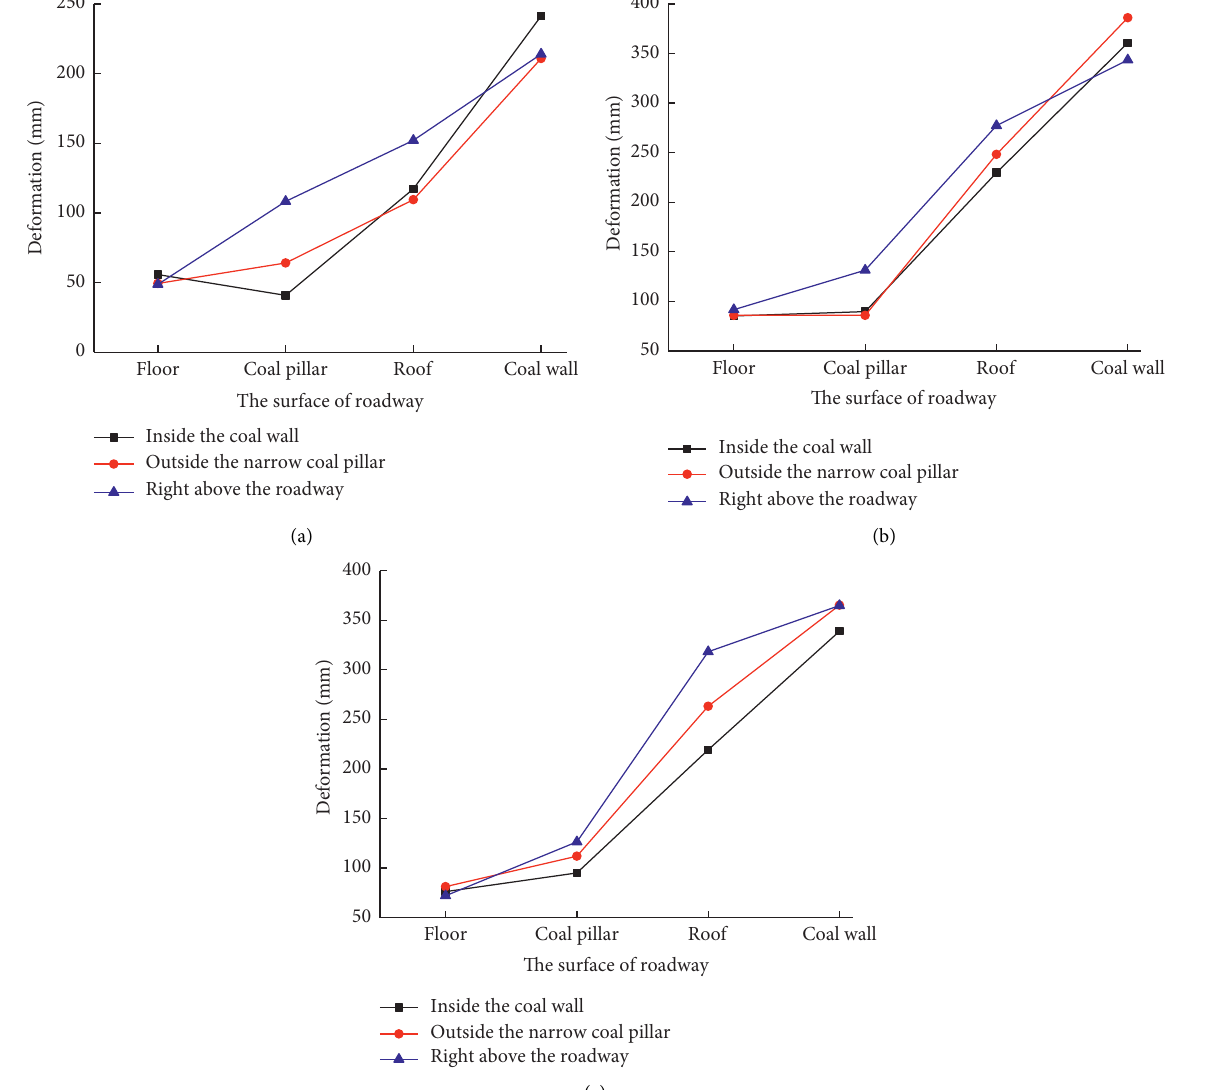
Figure 4: Deformation of surrounding rocks of roadways when the main roof fracture location is different. (a) The main roof height is 0m. (b) The main roof height is 5 m. (c) The main roof height is